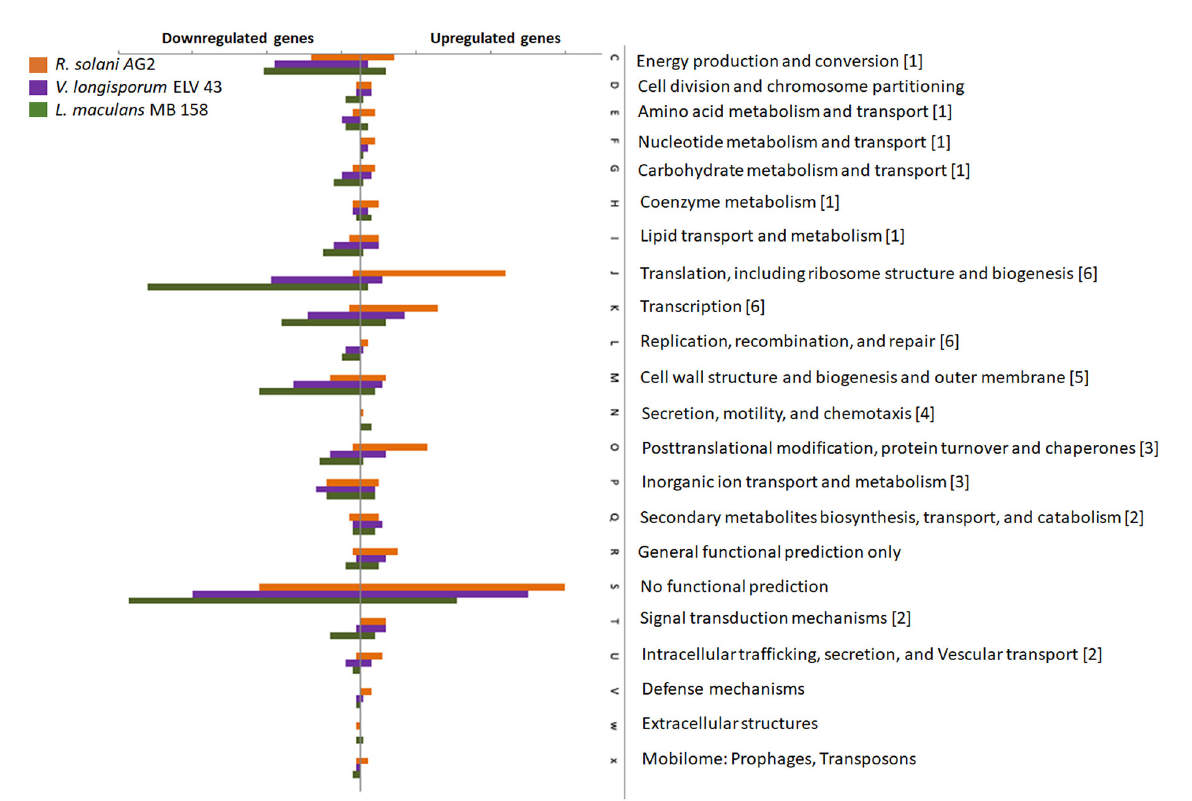
FIGURE4 Impact of fungal volatiles on gene expression in S. plymuthica HRO-C48. The number of genes with at least 1.5-fold change in relation to the untreated control is depicted. If a transcript was assigned to multiple classes, it was included in each of the assigned classes’ counts. Orange, violet, and green bars indicate genes with significantly changed expression due to the contact with R. solani AG2, V. longisporum ELV43 or L. maculans MB158 VOCs, respectively. The letters represent different COG functions, while numeric figures appended at the end of each COG function represent the functional classification of differentially expressed genes (DEGs). The genes in the diagram correspond to the genes listed in the Supplementary Table S2. The numbers in brackets correspond to the following functional annotations: 1: metabolism, 2: Extracellular communication, 3: Intracellular processes, 4: secretion, motility, and chemotaxis, 5: cellular structure, 6: genetic information